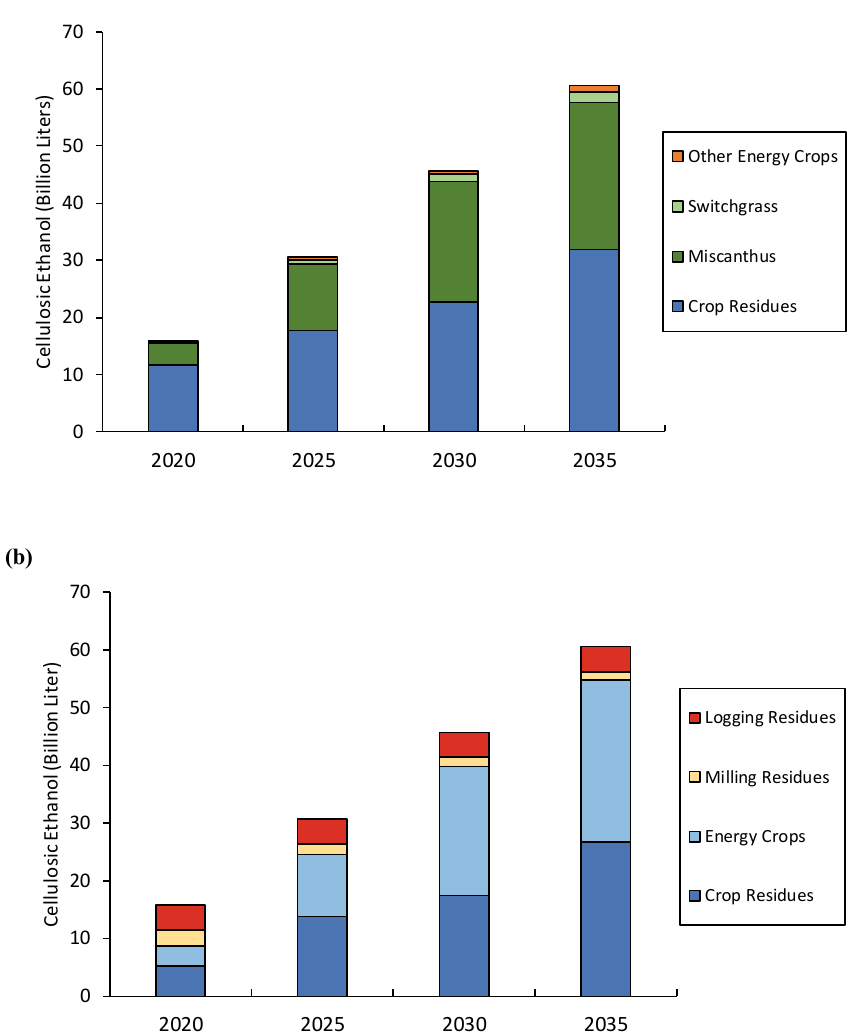
Figure 1. Optimal mix of feedstocks in cellulosic ethanol production under RFS by years. (a) Ag-only EtOH scenario; ( b ) Wood & Ag EtOH scenario.